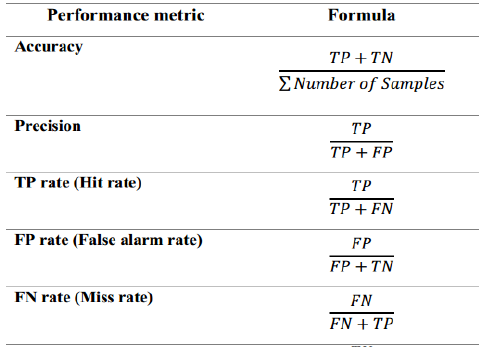
Table 2. Different performance metrics used for the evaluation of